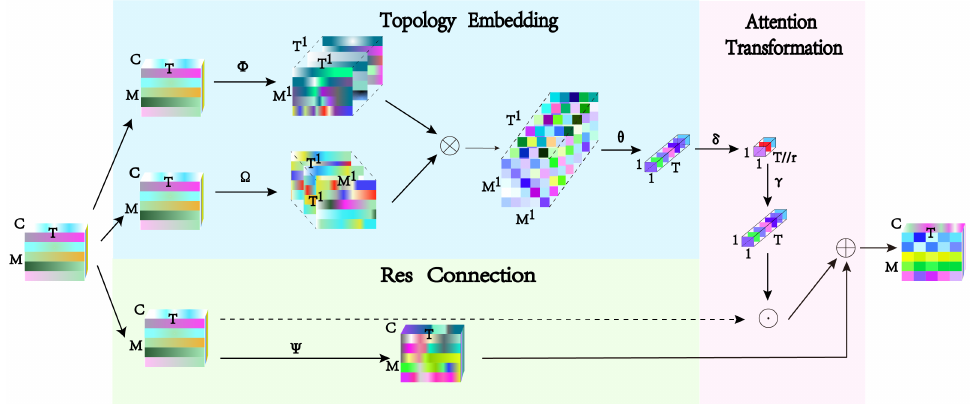
Figure 2. The structure of the proposed topology-embedded temporal attention module. Topology embedding is aimed at modeling the effective topology relationship, embedding as excitation features. Attention transformation completes the transformation of the excitation to the attention score. The goal of the residual connection is to restrict the output by the transformed